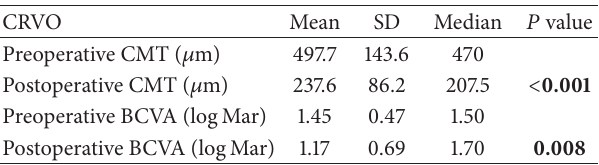
Table 2: Comparison of pre- and postoperative central macular thickness and best corrected visual acuity in